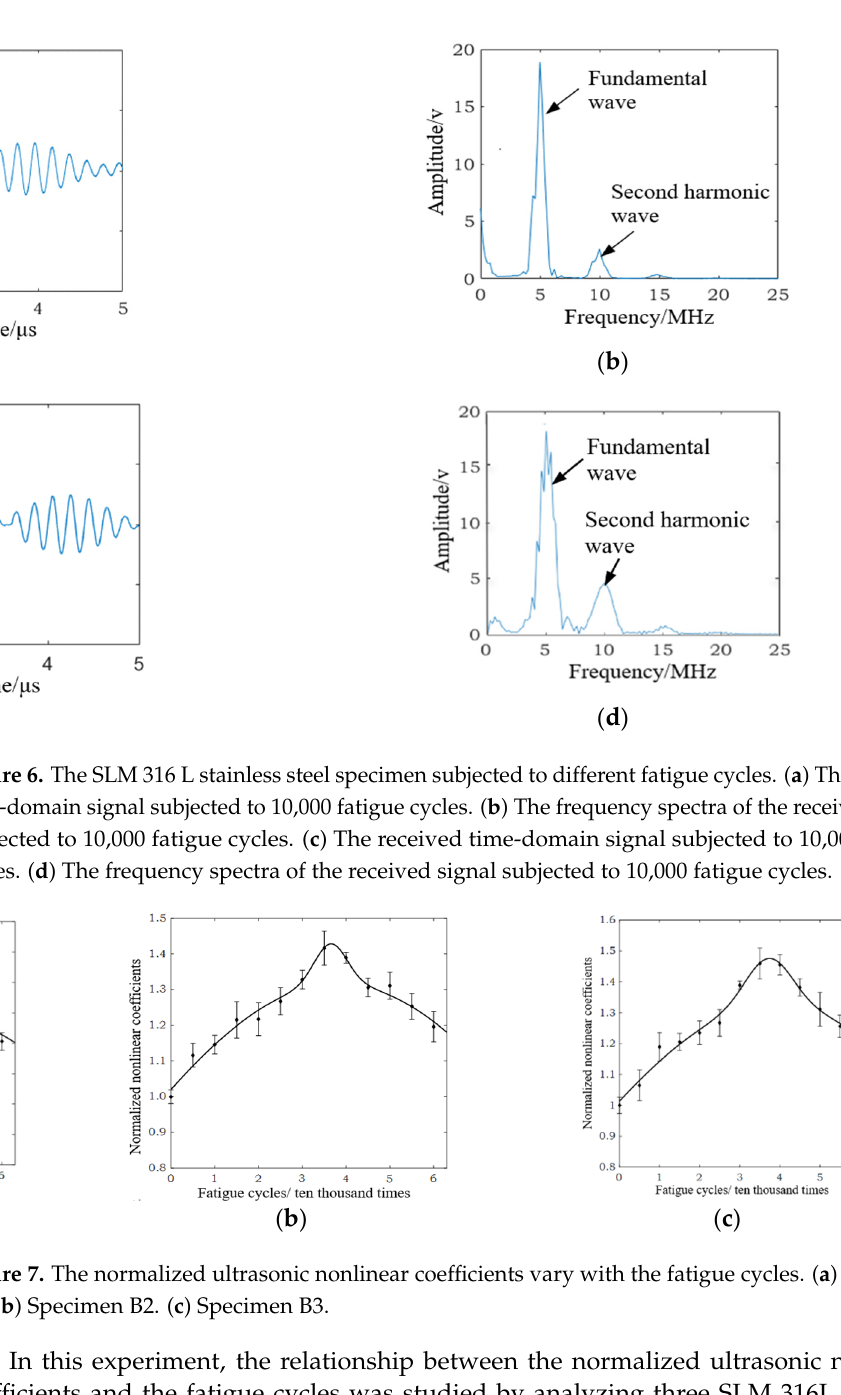
Figure 7. The normalized ultrasonic nonlinear coefficients vary with the fatigue cycles. ( a ) Speci ‐ men B1. ( b ) Specimen B2. ( c ) Specimen B3.